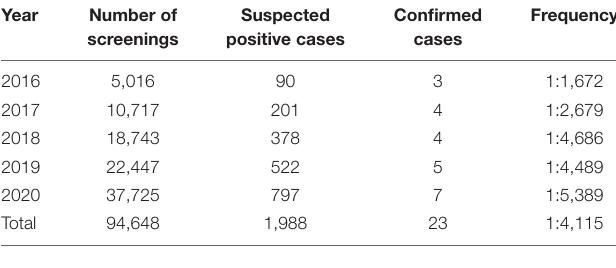
TABLE 2 | Newborn screening of the Shaoyang area from 2016 to 2020.